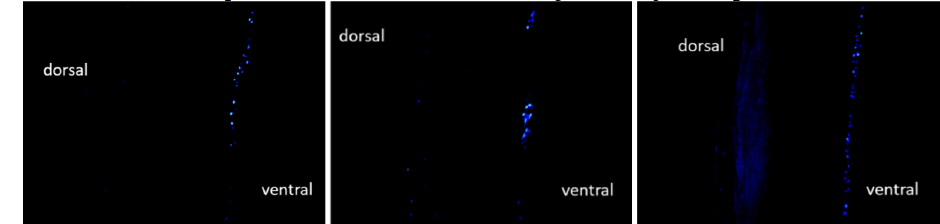
Figure 5. Cross-sectional anti-ceramide antibody staining and nuclear staining of healthy and nail